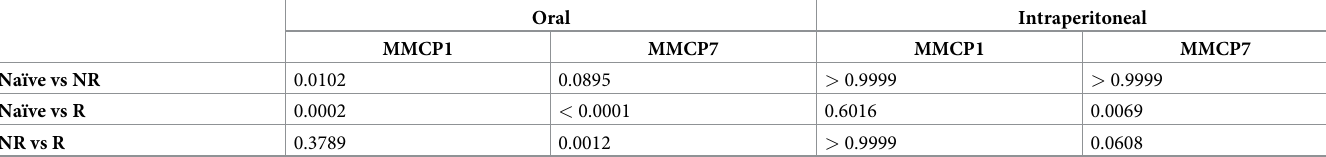
Table 2. Adjusted p values comparing MMCP-1 and MMCP-7 levels between naïve, non-responder (NR) and responder (R) C3H mice after oral or intraperitoneal challenge.